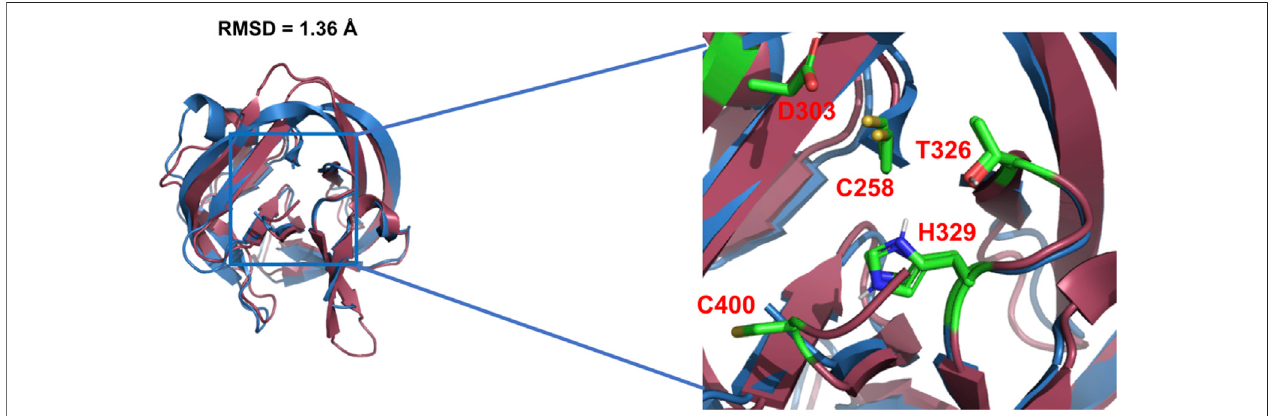
FIGURE 2 | 3D structures of Hh Hint and intein. Crystal structure of Drosophila Hh Hint domain (red, PDB: 1AT0) and intein (blue, PDB: 2IN0; an engineered mini- inteinbasedon Mtu RecA intein)havesimilar3Dstructures(RMSD=1.36 Å). Theimageontheright zoomsintheconserved residuesintheactivesite ofHintand intein.